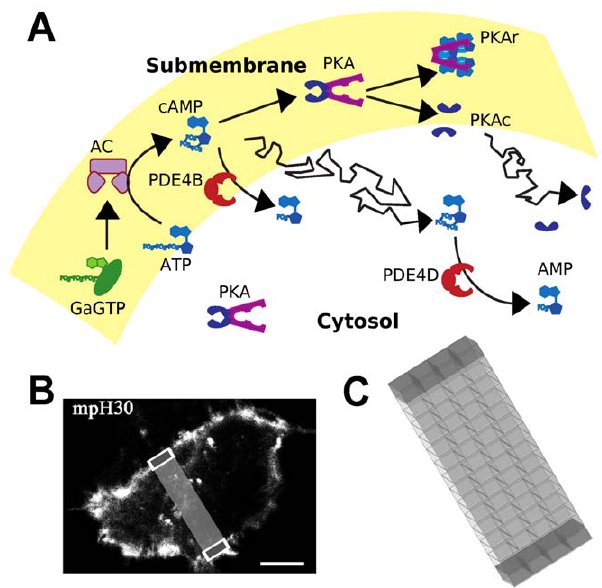
Figure 1. Schematic representation of the biochemical signal- ing pathway modeled. (A) G a GTP binds to and activates adenylate cyclase, which then produces cAMP from ATP. cAMP activates PKA, a heterotetramer with two regulatory and two catalytic subunits. After binding 4 molecules of cAMP, the two catalytic subunits (PKAc) dissociate from the regulatory subunit dimer (PKAr) and become active [26,27]. cAMP is degraded by phosphodiesterase, type 4B (PDE4B) and type 4D (PDE4D). AC, G a GTP, PKA and PDE4B are anchored at the submembrane while PKA and PDE4D are distributed throughout the cytosol. cAMP, ATP, AMP and PKAc freely diffuse. (B) Confocal image showing the localization of the membrane-targeted version of the unimolecular Epac-based sensor for cAMP (mpH30) in HEK293 cells. Confocal images were acquired 24 hours after transfection by using the broadband confocal Leica TCS SP5 system (Leica Microsystems) and a HCX PL APO 63x1.4NA oil-immersion objective (scale bar 10 m m). The representation superimposed on the micrograph corresponds to the grid in C. (C) Schematic representation of the spatial structure of the HEK293 cell model, light gray compartments correspond to the cytosol while dark gray compartments correspond to the submembrane region in a slice of the 3-dimensional